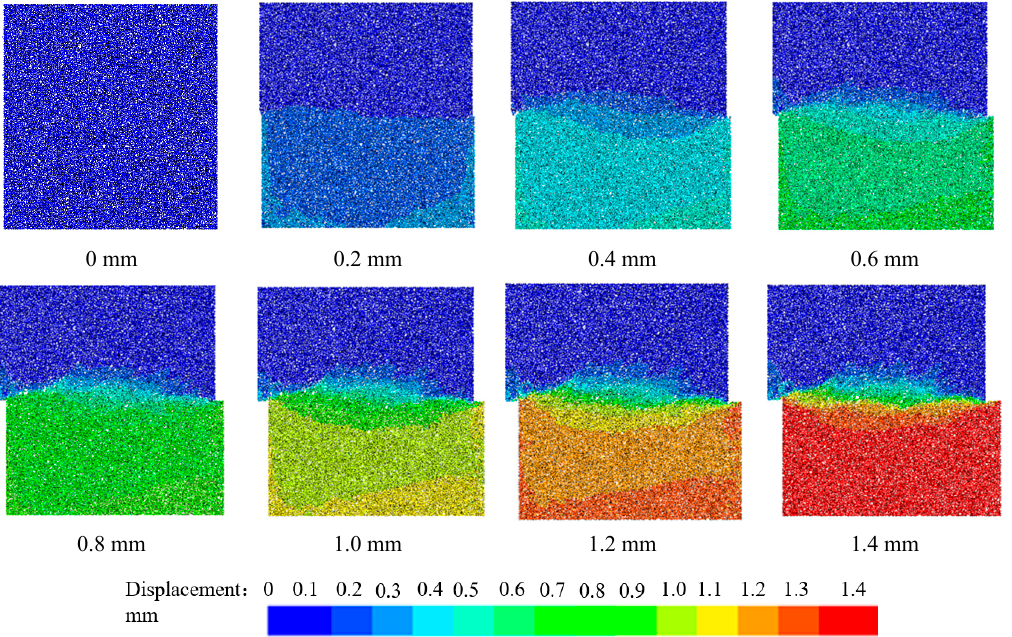
Figure 14. In the direct shear test, the particle displacement nephogram of natural gas hydrate sediments with normal stress of 1.2 MPa and saturation of 30%.